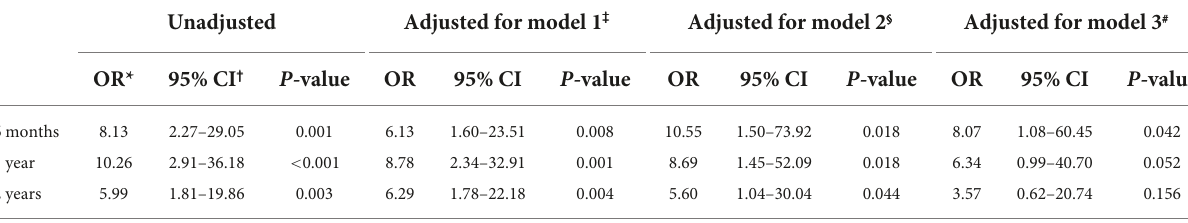
TABLE 3 Logistic regression showing odds ratio (OR) for outcomes of death/myocardial infarction (MI) at 6 months, 1 year, and 2 years according to plasma desmosine (pDES) levels (unadjusted and adjusted for models 1, 2, and 3). Unadjusted